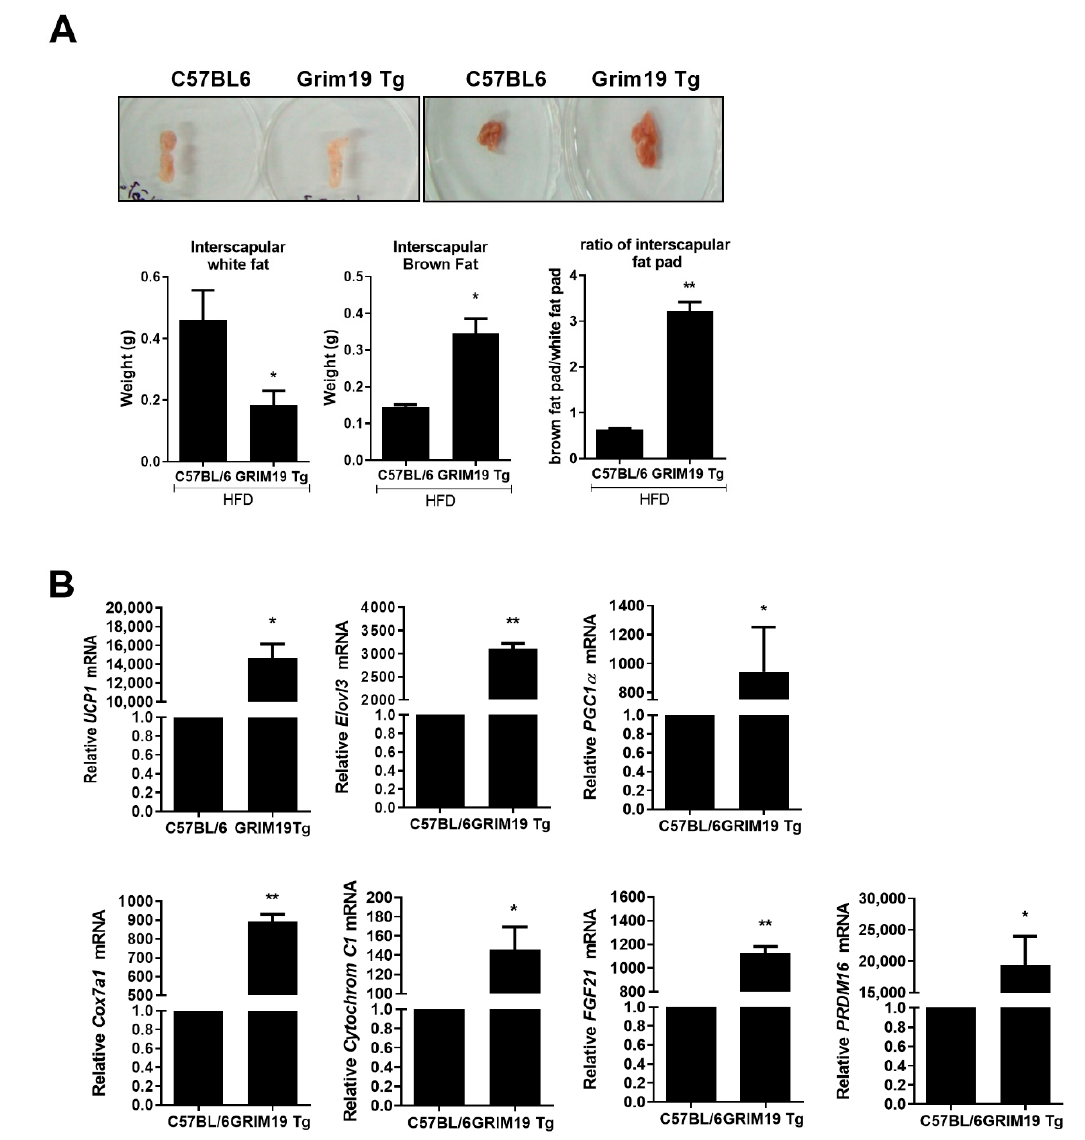
Figure 6. GRIM19-mediated anti-adipogenic and thermogenic effects in GRIM19-Tg and WT mice. ( A ) Representative images of interscapular white fat and interscapular brown fat from HFD-fed WT and GRIM19-Tg mice (top). Bar graphs show the averaged weights of interscapular white fat and interscapular brown fat, and ratios of interscapular white fat weight to that of interscapular brown fat in interscapular fat pads (bottom). ( B ) Transcript levels of UCP1 , Elovl3 , PGC1a , Cox7a1 , cytochrome C1 , fibroblast growth factor (FGF) 21 , and PRDM16 in epididymal fat pads from HFD-fed WT and GRIM19-Tg mice. The transcript levels were normalized to that of GAPDH. Mice were housed at 4 ◦ C for 1 day before the experiments. Data are presented as the means ± SDs of three independent experiments. * p < 0.05 and ** p <